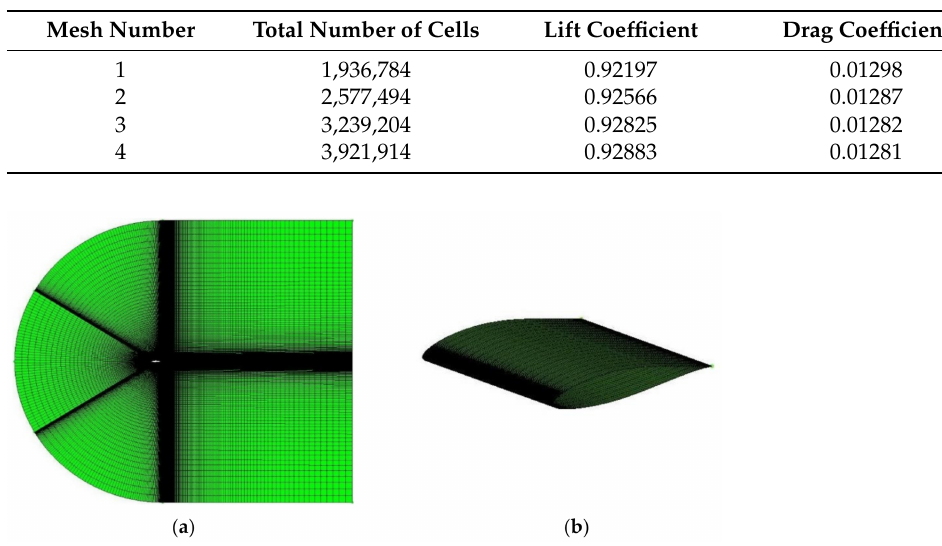
Table 6. Comparison of hydrodynamic performance under different grid resolutions.